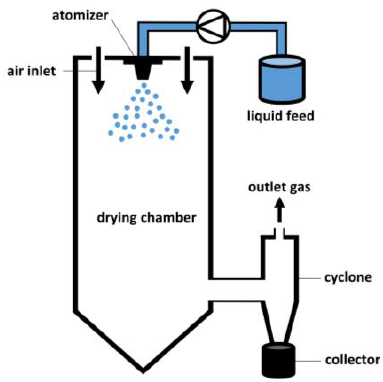
Figure 9. Schematic diagram of a spray drying setup.